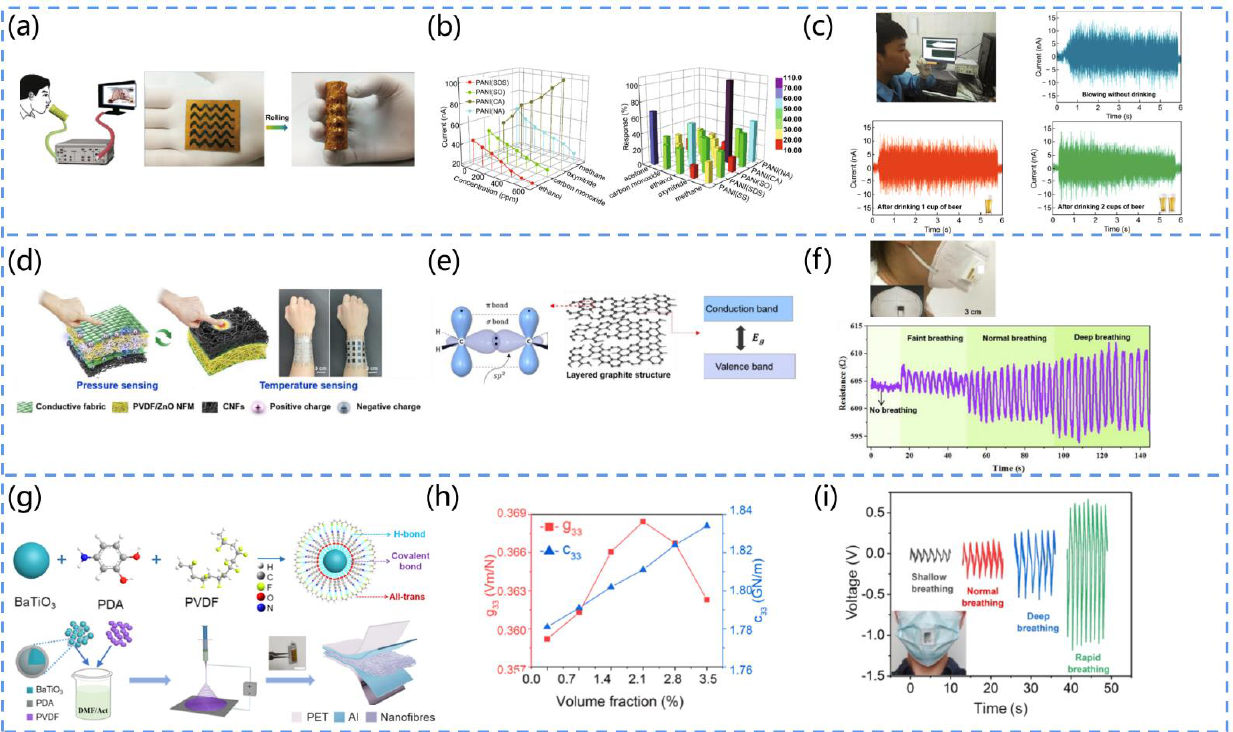
Figure 10. ( a ) Working principle and structure of PANI/PVDF-based piezoelectric sensors. ( b ) Relationship between the gas marker concentrations of each sensing unit. ( c ) Schematic diagram of fatty liver diagnosis by the monitoring of alcohol. Reprinted with permission from [117]. Copyright 2018, Springer Link. ( d ) Schematic diagram of the structure and sensing mechanism of the device. ( e ) Diagram of the preparation process of CNFs. ( f ) Output voltage at different frequencies of breathing. Reprinted with permission from [126]. Copyright 2021, Elsevier. ( g ) Schematic diagram of the process of piezoelectric fabrics modified with polydopamine. ( h ) Piezoelectric voltage coefficient and stiffness coefficient of piezoelectric fabrics with different PDA contents. ( i ) Schematic diagram of the output of piezoelectric fabrics with different breathing modes. Reprinted with permission from [132] Copyright 2021, Elsevier.